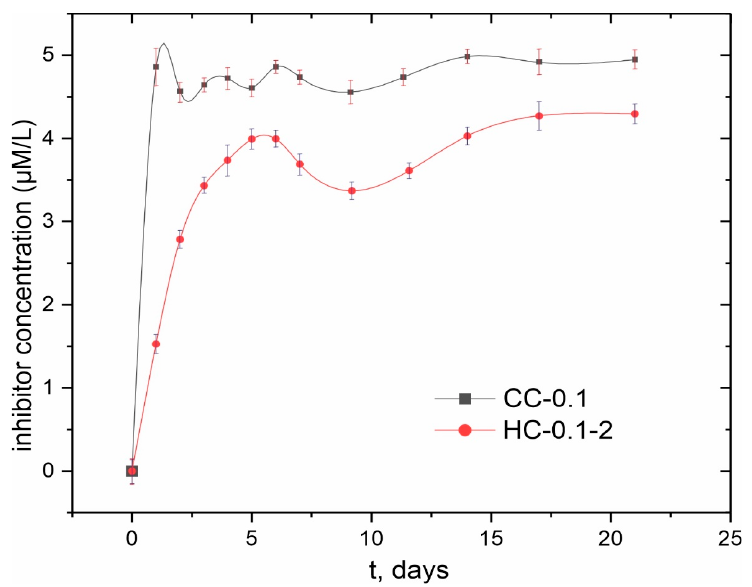
Figure 10. Evolution of the inhibitor release for CC-0.1 and HC-0.1-2 samples exposed to 0.9.wt% NaCl solution for 21 days.